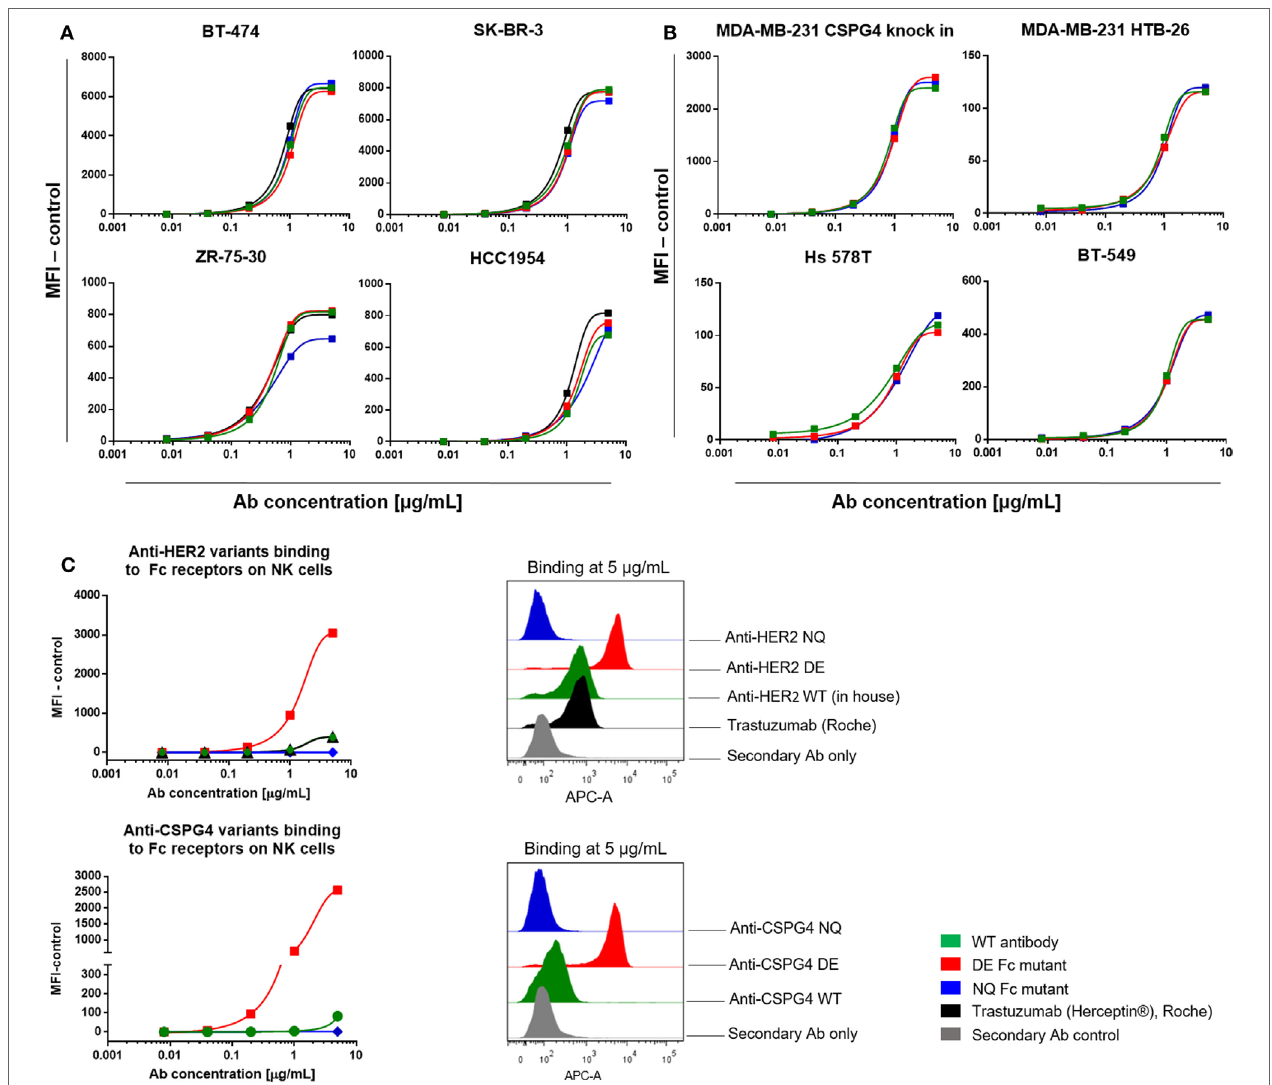
FigUre 5 | Antibody target antigen and Fc receptors (FcRs) binding evaluations. (a) Target antigen recognition of anti-HER2 Fc variants on HER2-overexpressing cancer cell lines. All anti-HER2 Fc variants including the positive control trastuzumab (Herceptin ® , Roche) bound to the target antigen in a similar dose-dependent manner. (b) Target recognition of anti-chondroitin sulfate proteoglycan 4 (CSPG4) Fc variants on triple-negative breast cancer cell lines. All the anti-CSPG4 Fc variants bound to the target antigen in a similar dose-dependent manner. (c) Left: binding of anti-HER2 (top) and anti-CSPG4 (bottom) Fc variants to Fc γ RIII on fresh human peripheral blood NK cells with increasing antibody concentrations (0.008–5 µg/mL). Right: flow cytometric histograms depicting antibody binding at saturating concentrations (5 µg/mL). Graphs are representative of two independent experiments; data were normalized against an isotype control (a,b)